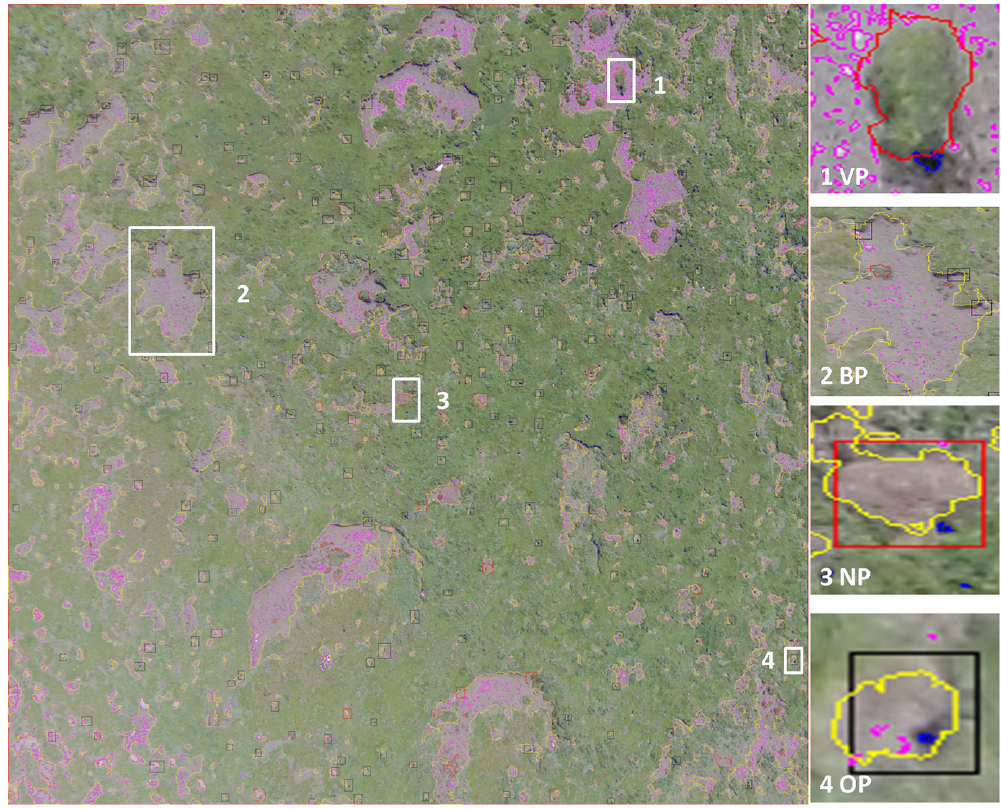
Figure 5. An aerial photo and contours of vegetation patch (red curves, VP), bald patch (yellow curves, BP), new pika pile (red rectangles, NP), old pika pile (black rectangles, OP), and enlarged examples on the right for each type. Pink contour indicates